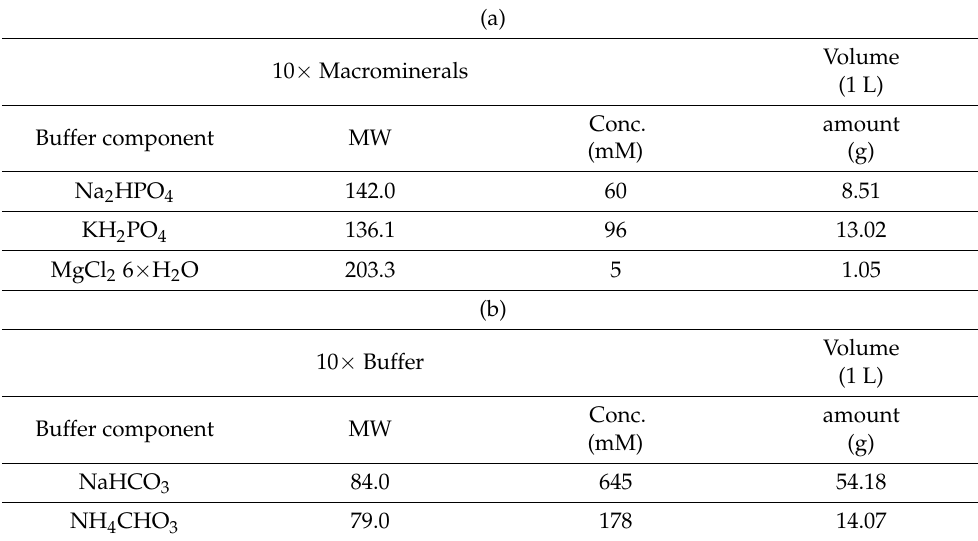
Table 2. The quantity of each component used in one litre (a) buffer 1 and (b) buffer